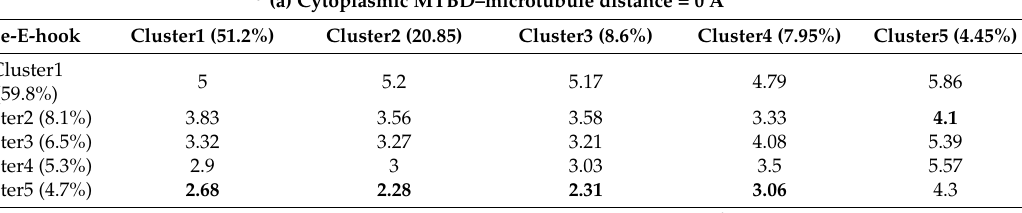
Table 3. Cluster analysis of the conformational states for the E-hook in chain D. First five populated clusters of the E-hook in chain D for an isolated state (microtubule only) and a bound state (MTBD bound to microtubule). The root-mean-square deviation (RMSD) values between each representative of E-hooks in a free state and E-hooks in a bound state were shown in each block in Å, and the minimum values were